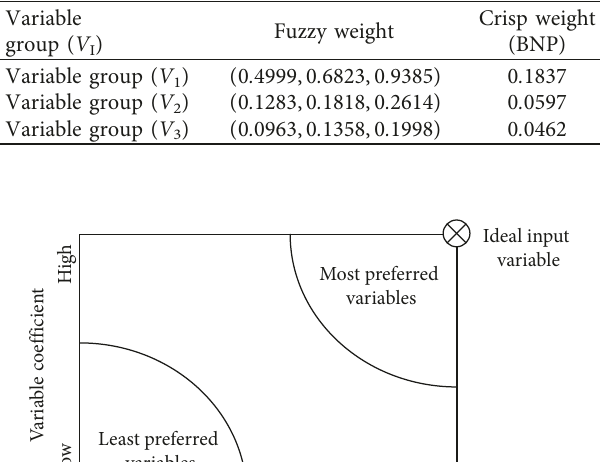
Table 7: The weight of variable groups with respect to the goal.